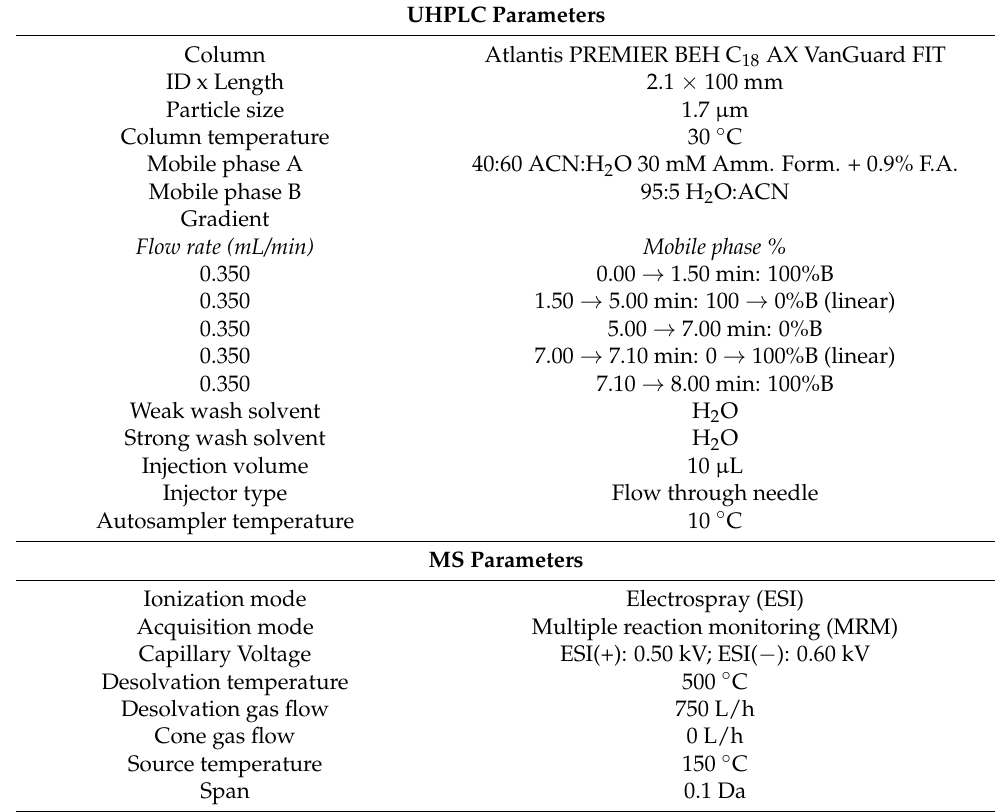
Table 3. UHPLC and MS parameters for the Organic Acids second-tier